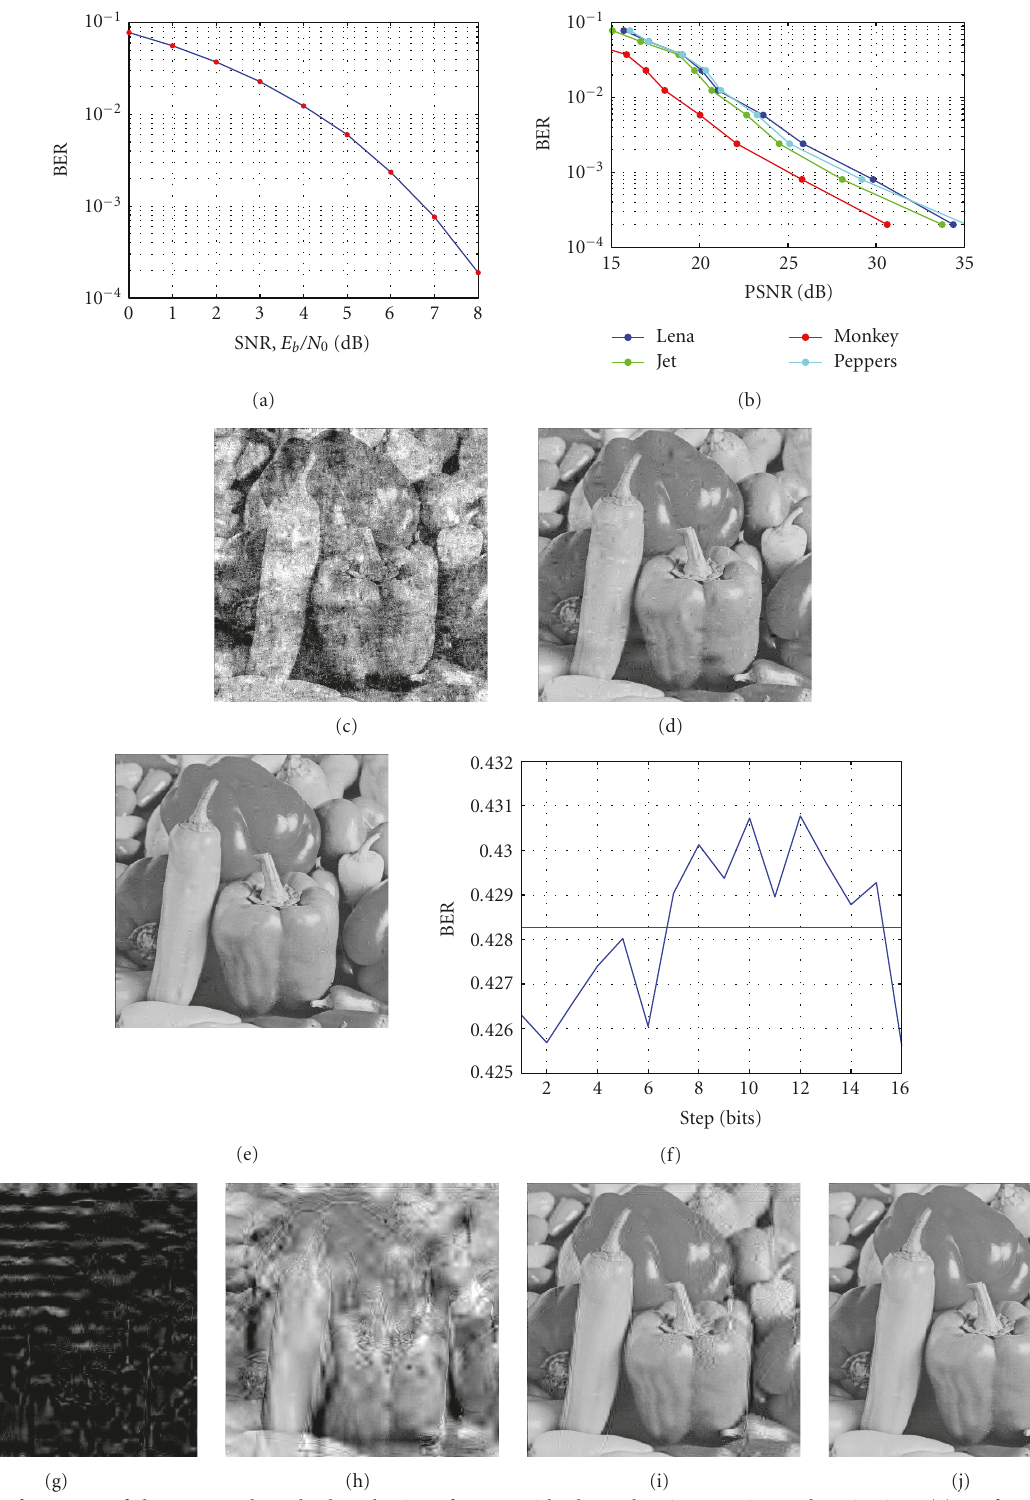
Figure 8: Performance of the proposed method under interference with channel noise or mis-synchronization: (a) performance of an ordinary communication system, (b) quality of the reconstructed images (PSNR, dB) at di ff erent bit-error rate, (c) reconstructed Peppers image with PSNR of 16 . 04dB at bit-error rate of 8 × 10 − 2 , (d) reconstructed Peppers image with PSNR of 25 . 10dB at bit-error rate of 2 . 4 × 10 − 3 , (e) reconstructed Peppers image with PSNR of 35 . 14dB at bit-error rate of 2 . 0 × 10 − 4 , (f) average bit-error rate at di ff erent misalignment steps, (g) reconstructed Peppers image with PSNR of 5 . 67dB for 1 bit misalignment from the beginning, (h) reconstructed Peppers image with PSNR of 11 . 88dB for 1-bit misalignment after 5 percent of the shadow data was transmitted, (i) reconstructed Peppers image with PSNR of 24 . 16dB for 8-bit misalignment after 20 percent of the data was transmitted, and (j) reconstructed Peppers image with PSNR of 30 . 15dB for 10-bit misalignment after 50 percent of the data was